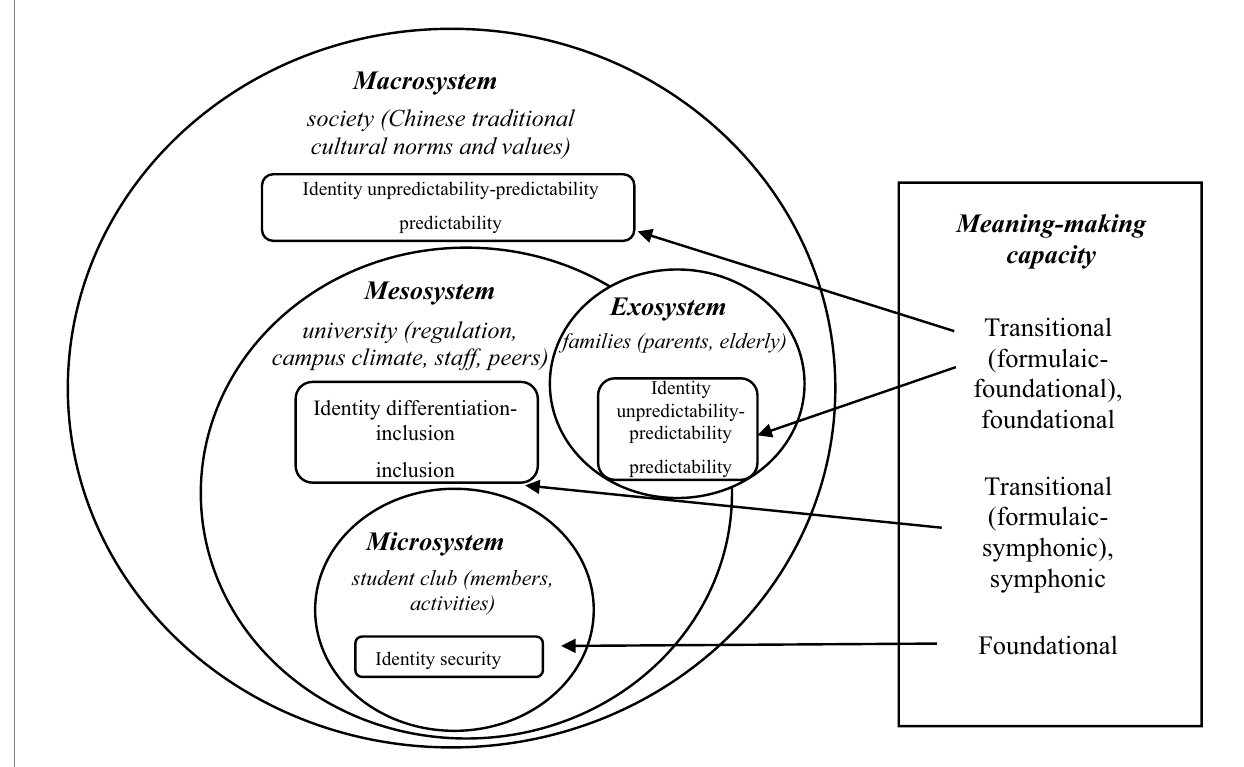
FIGURE 1 Meaning-making capacity enabled identity negotiation in the ecology of environmental systems